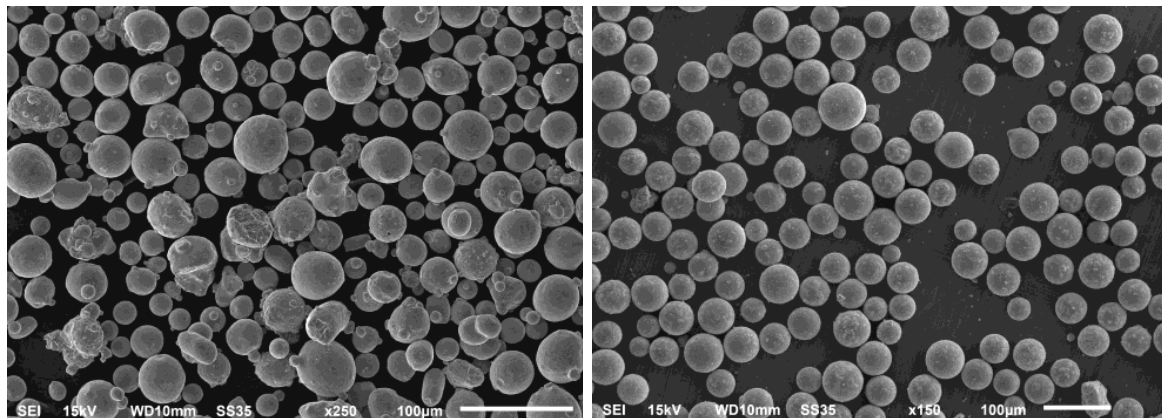
Figure 4. SEM scans of PAGA ( left ) and UA ( right ) particles as tested — the same scale. Based on the obtained images, there are visible differences between the two powders.